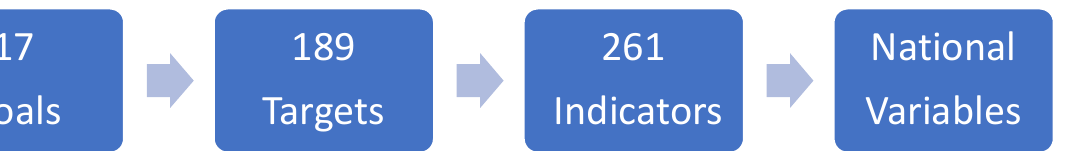
Figure 1. Goals of Agenda 2030 [5].